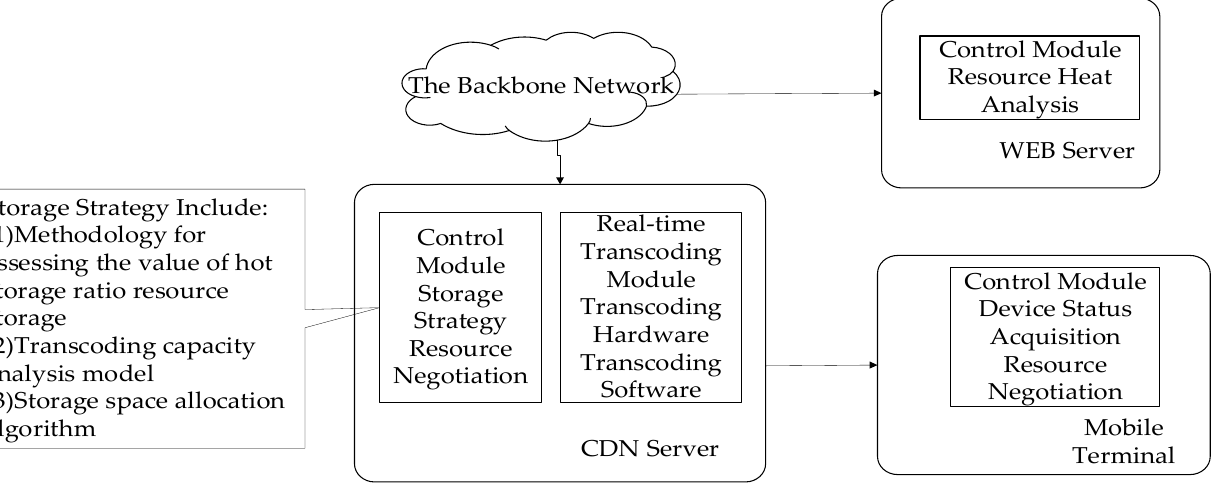
Figure 1. Architecture of the distributed real-time transcoding CDNs.